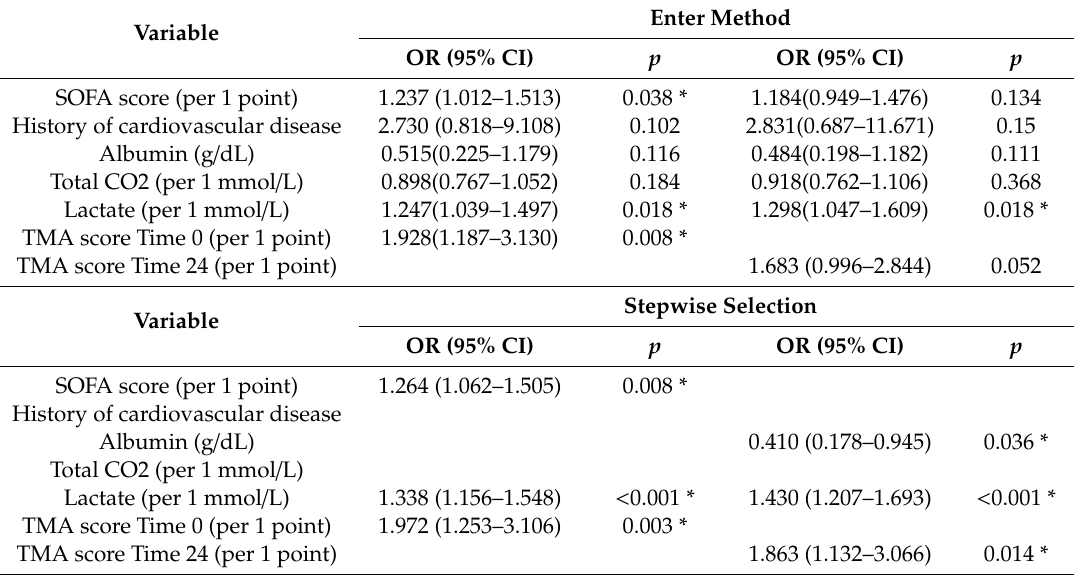
Table 2. Multivariable logistic regression analysis for predictors of 30-day